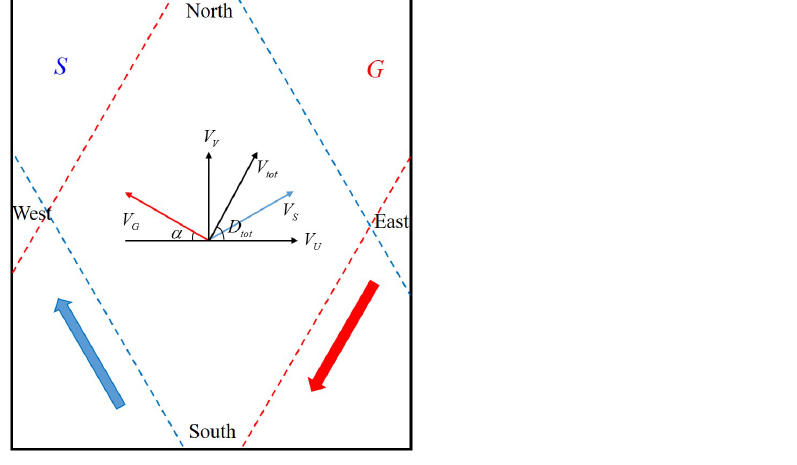
Figure 1. Schematic diagram of the geometric relationship between the sea-surface velocity and its components in the trajectory-crossing